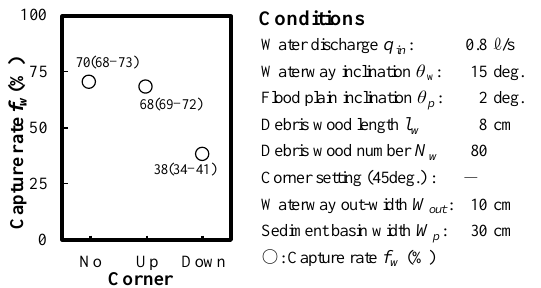
Figure 17. Effects of the difference in the presence or absence of corners on the wood debris capture rate.